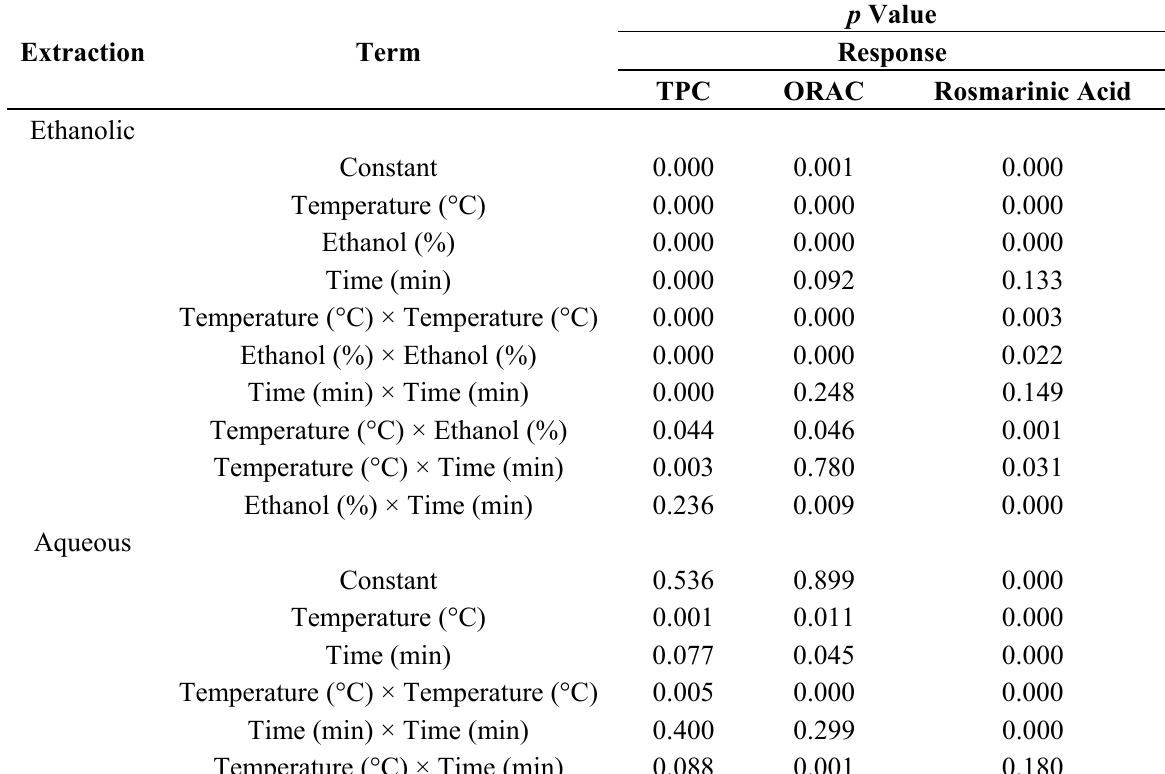
Table 5. p -Values for each of the constants in the equation of the mathematical model. Extraction